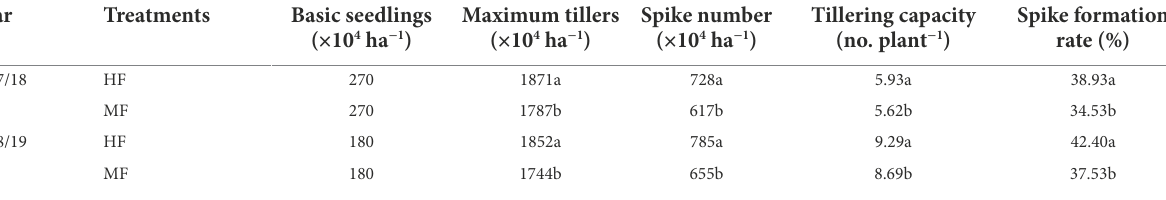
TABLE 2 Effects of soil fertility on tillering and spike-forming characteristics of wheat in 2017/18 and 2018/19 growing seasons.